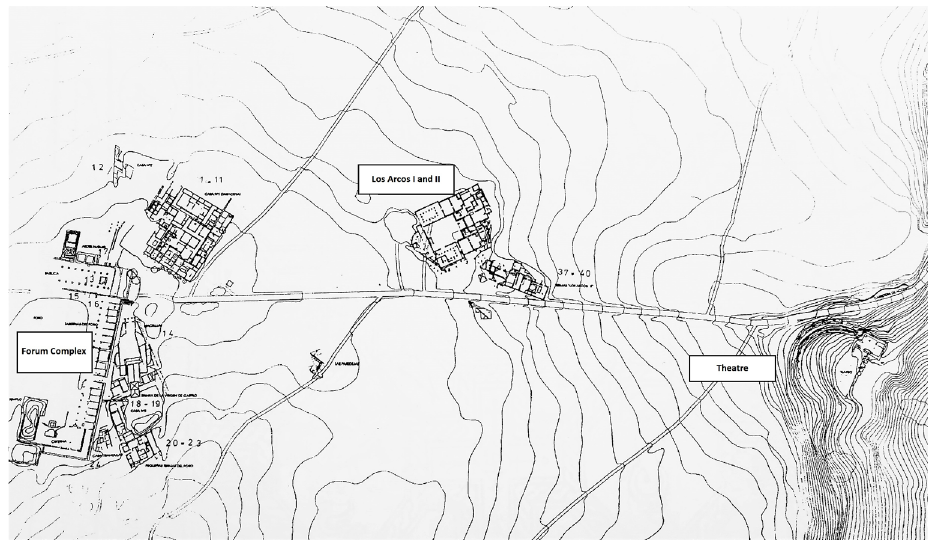
Figure 1: Plan of Clunia (after López Monteagudo et al. 1998, fig.